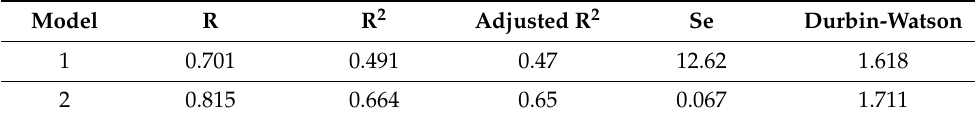
Table 10. Statistical values obtained from regression analysis for turbidity removal efficiency models.